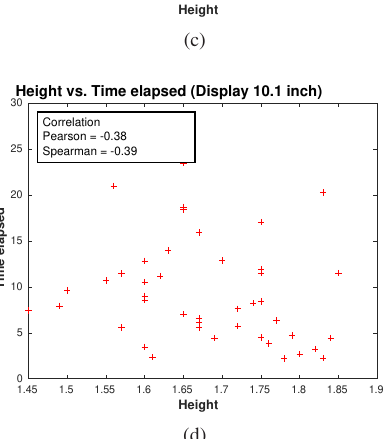
Figure 7. Correlation between the height of the volunteers and their perfor- mance. (a) data from all volunteers, (b) data from volunteers that used a 5.5 inch display, (c) data from volunteers that used a 7 inch display and (c) data from volunteers that used a 10.1 inch